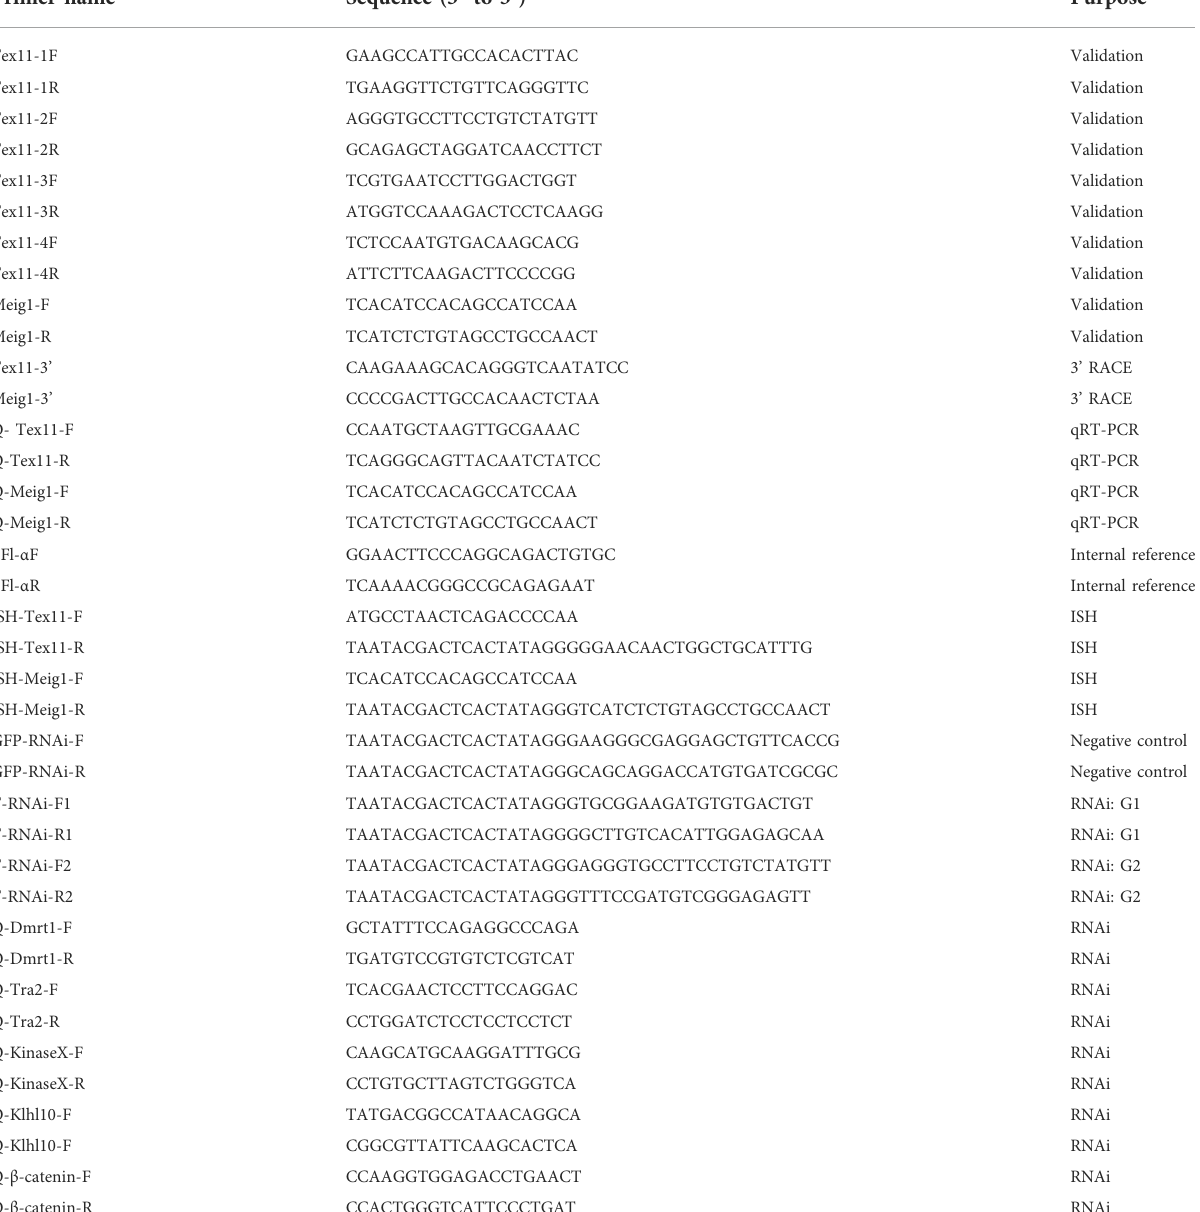
TABLE 1 Primer names and